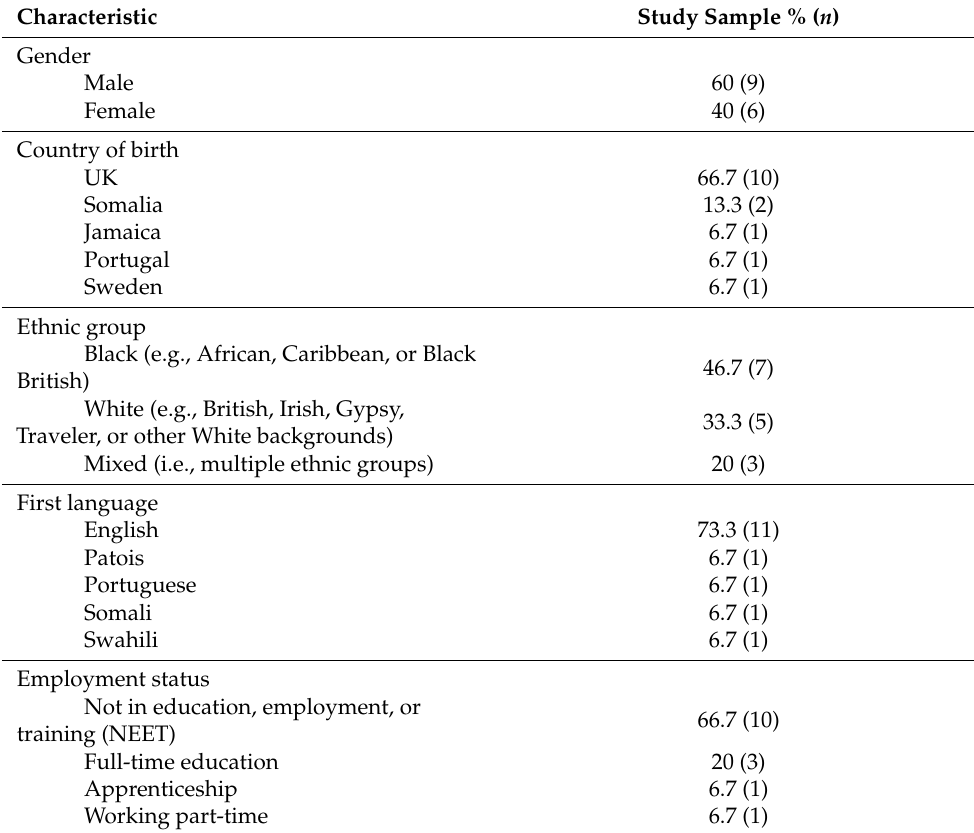
Table 3. Demographic characteristics of the study